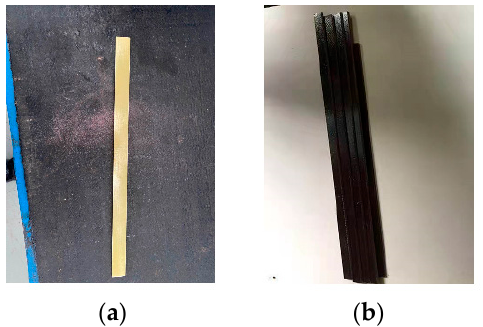
Figure 11. Stator slot wedge: ( a ) resin slot wedge; ( b ) magnetic slot wedge.